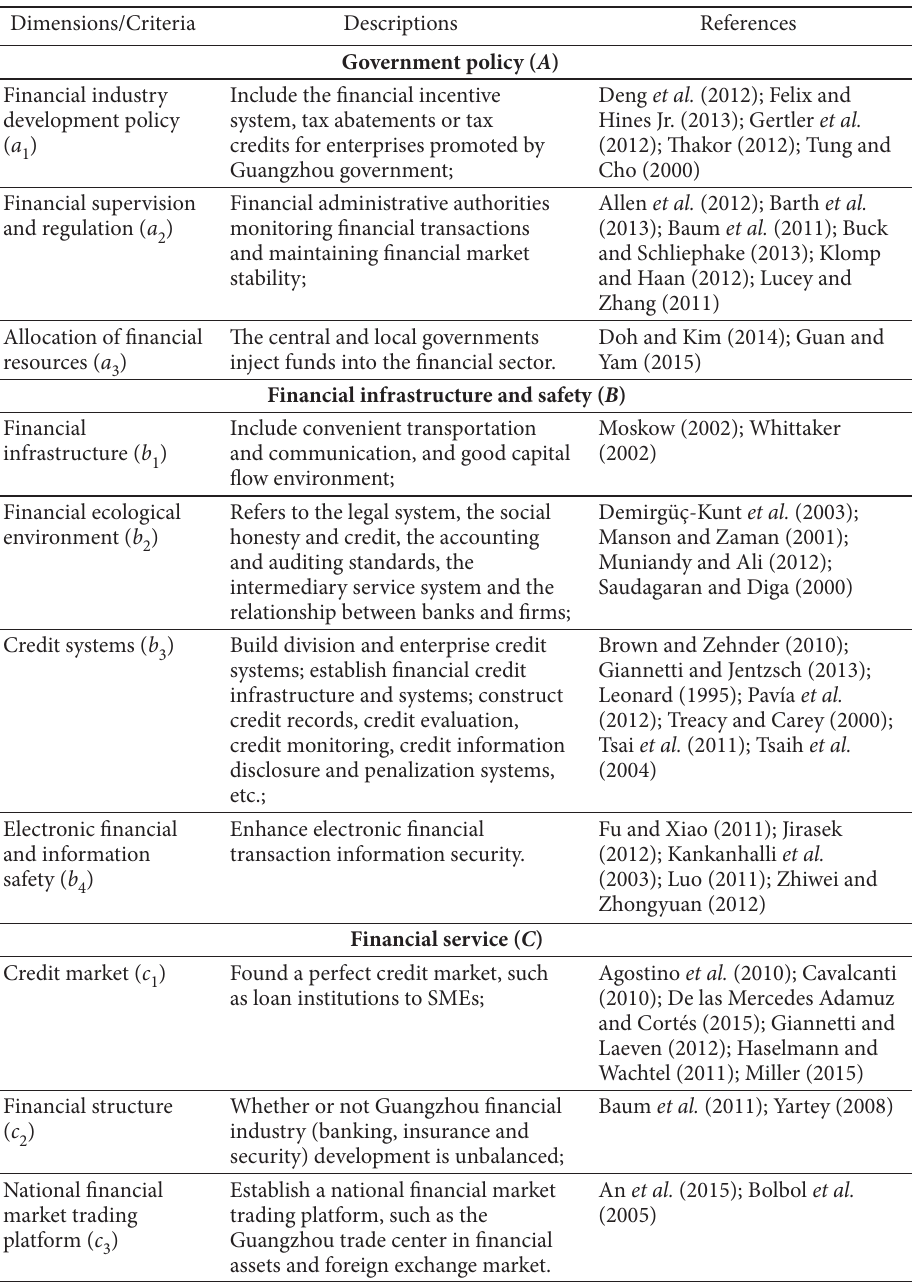
Table 2. Regional financial center modernization evaluation factors